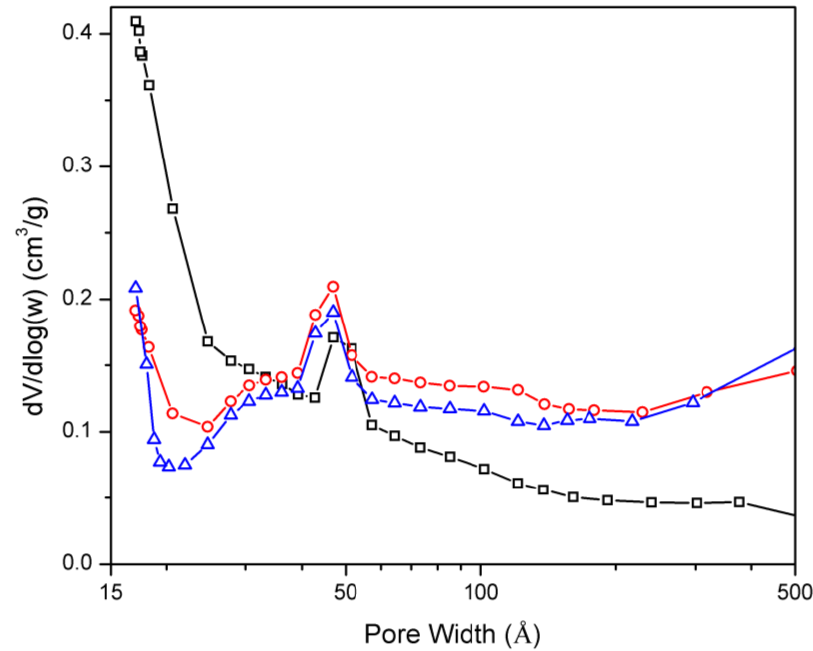
Figure 2. BJH pore size distribution of the (□) parent NaX zeolite, ( ○ ) Co/NaX, ( △ ) and recycled Co/NaX.